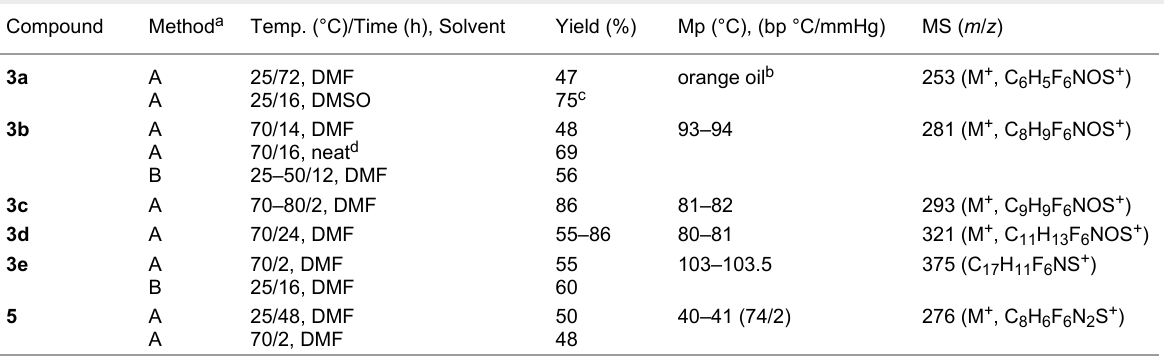
Table 1: Reaction conditions, yields, melting/boiling points and MS data for compounds 3a–e and 5 .